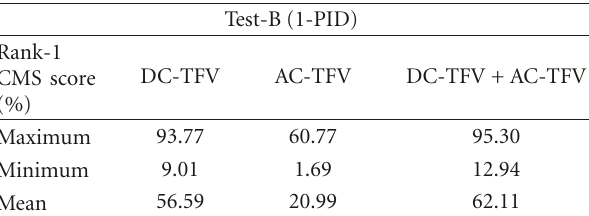
Table 2: Results of using single subarea.